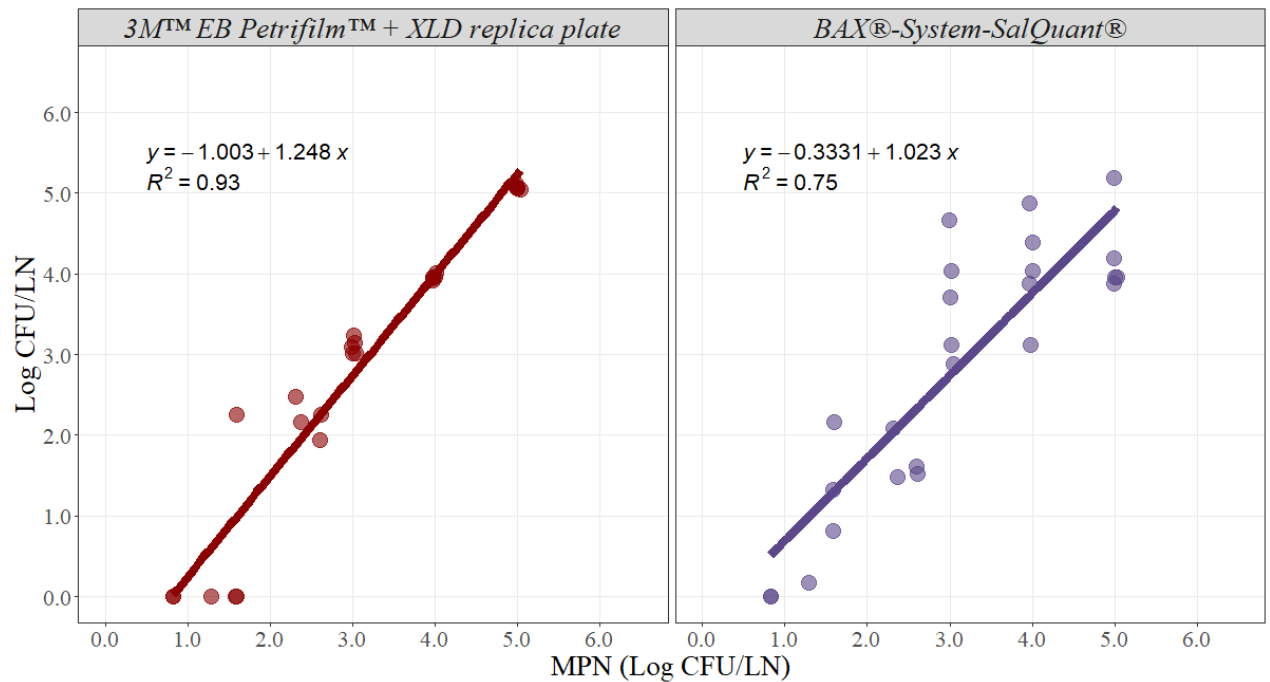
Figure 3. Graphical representation of the linear correlation comparing 3M™ EB Petrifilm™ + XLD replica plate and BAX ® -System-SalQuant ® versus most probably number (MPN) for quantification of Salmonella in pork lymph nodes (n = 25 per method). The dots represent the actual data points. when the independent variable is equal to zero. For this case, the intercept represents the